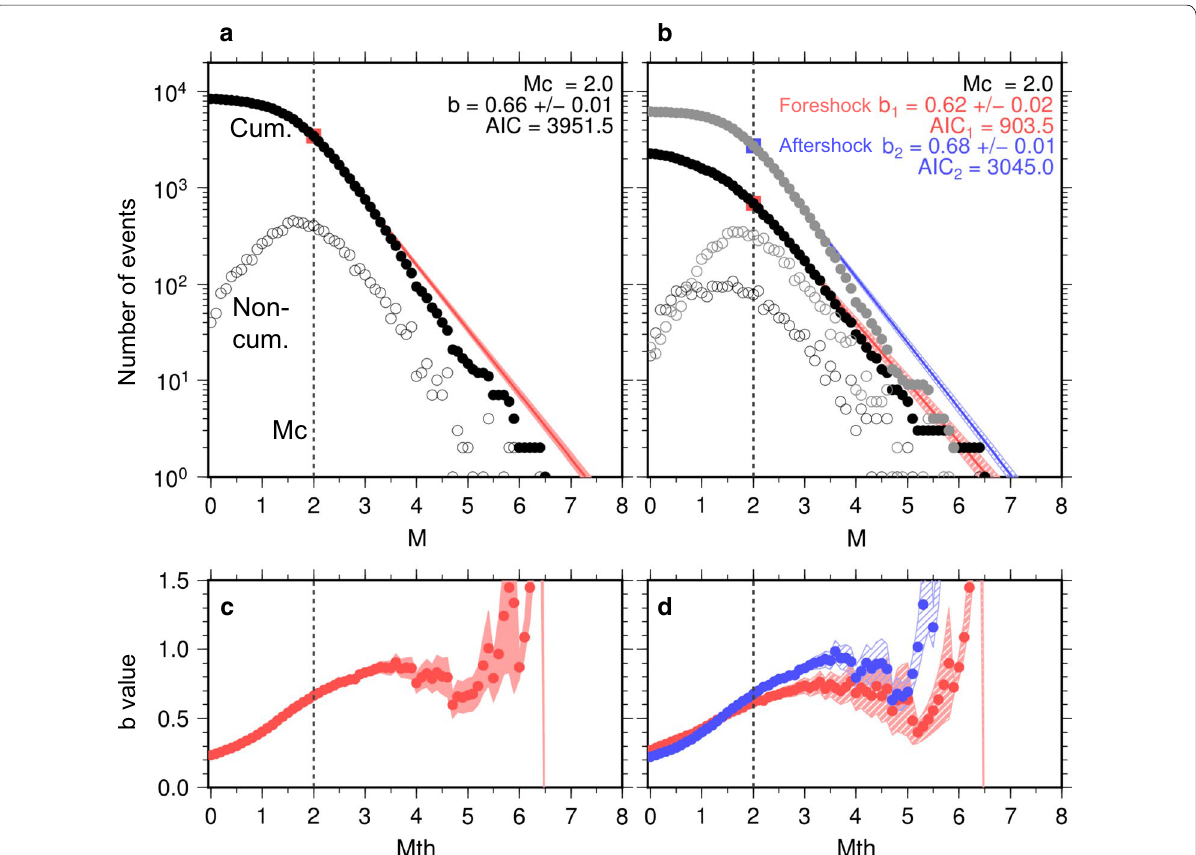
Fig. 4 Frequency–magnitude distributions of the 2016 Kumamoto earthquake sequence. a , b Frequency magnitude distributions and c , d b -value versus magnitude: a , c for the entire sequence (foreshocks and aftershocks), mainshock excluded, and b , d for the foreshocks and aftershocks, separately. The red and blue colors indicate foreshocks ( b 1 ) and aftershocks ( b 2 ), respectively. The frequency–magnitude distributions show both the cumulative (black) and noncumulative number (light gray) of events. The dashed black line indicates Mc estimated by the MAXC